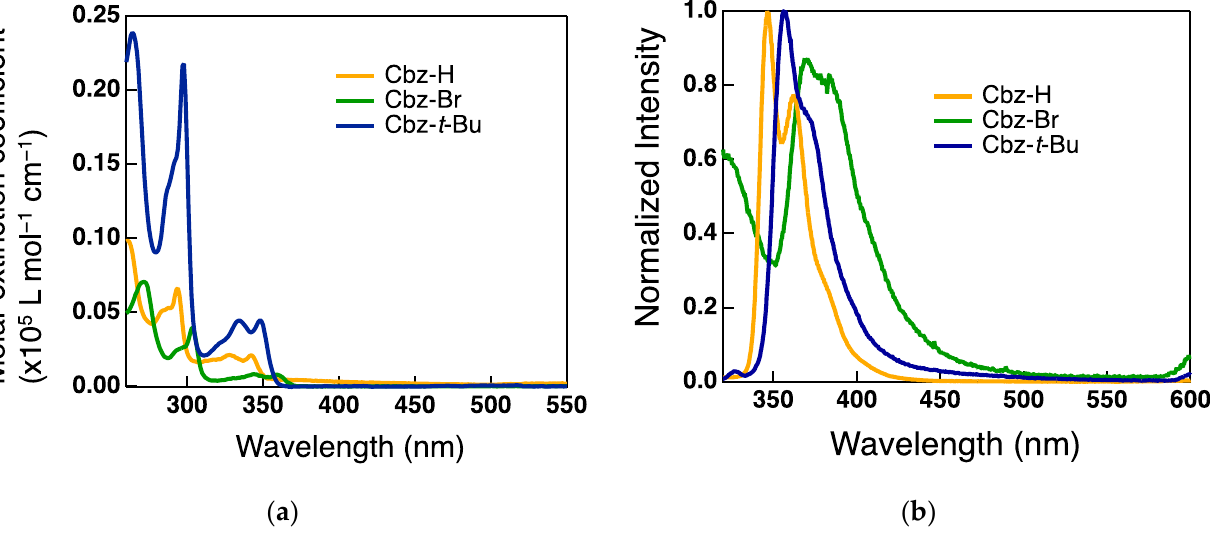
Figure 4. ( a ) UV – Vis absorption spectra of complex Cbz-R in CH 2 Cl 2 solution: [ Cbz-H ], 2.1 × 10 −5 mol L −1 ; [ Cbz-Br ], 4.3 × 10 −5 mol L −1 ; [ Cbz- t -Bu ], 3.3 × 10 −5 mol L −1 . ( b ) Normalized emission spectra of complex Cbz-R in CH 2 Cl 2 solution: [ Cbz-H ], 2.1 × 10 −5 mol L −1 , λ ex = 293 nm; [ Cbz-Br ], 4.3 × 10 −5 mol L −1 , λ ex = 300 nm; [ Cbz- t -Bu ], 3.3 × 10 −5 mol L −1 , λ ex = 297